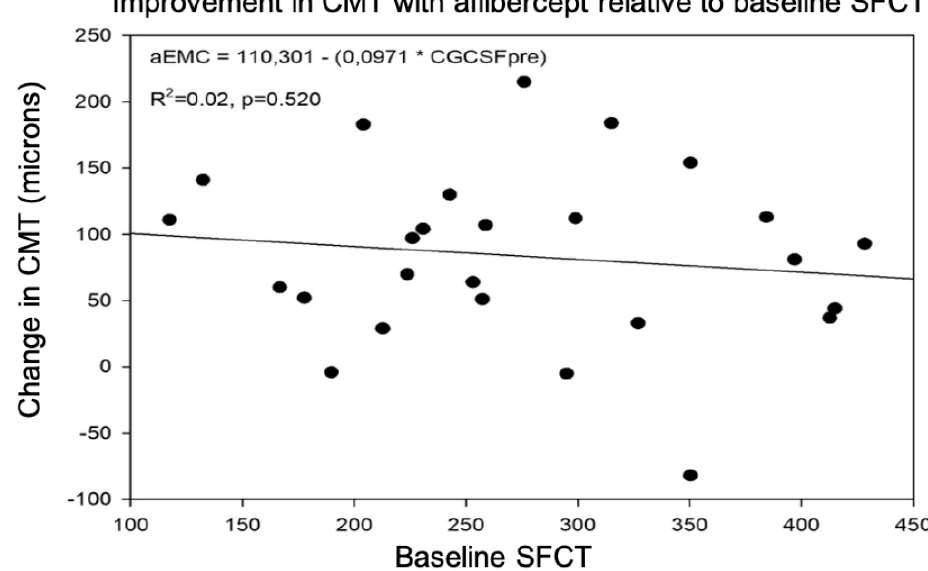
Figure 2. Changes in central macular thickness (CMT) related to baseline subfoveal choroidal thickness (SFCT) after intravitreal therapy with aflibercept.